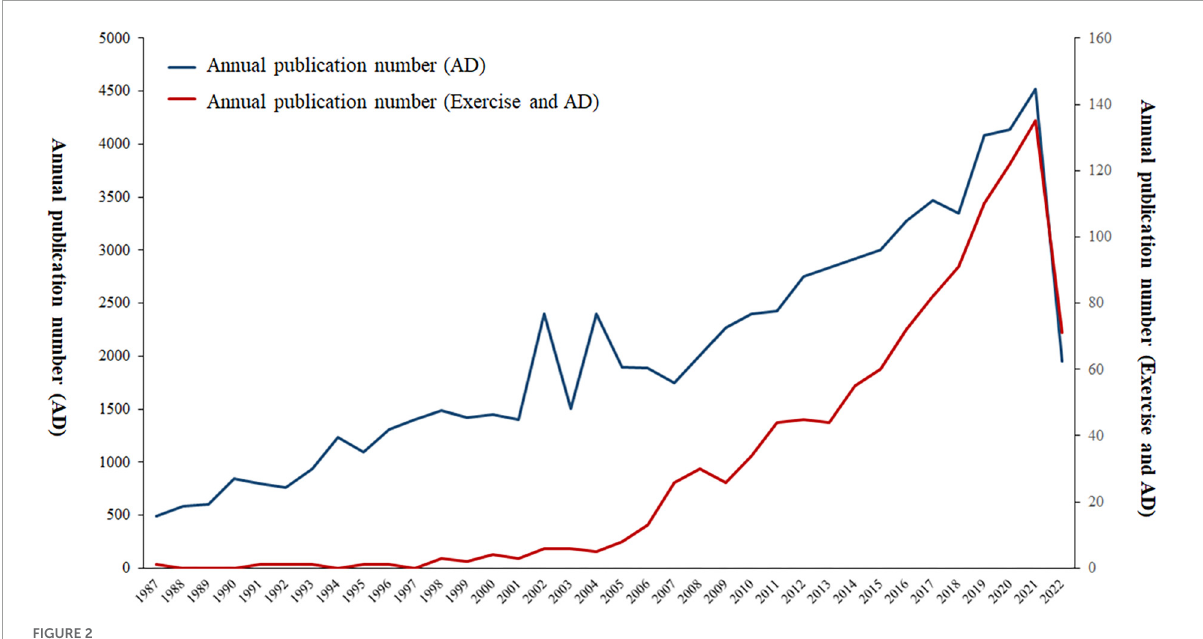
FIGURE2 Annual number of publications on AD, exercise and AD from 1987 to 2022.